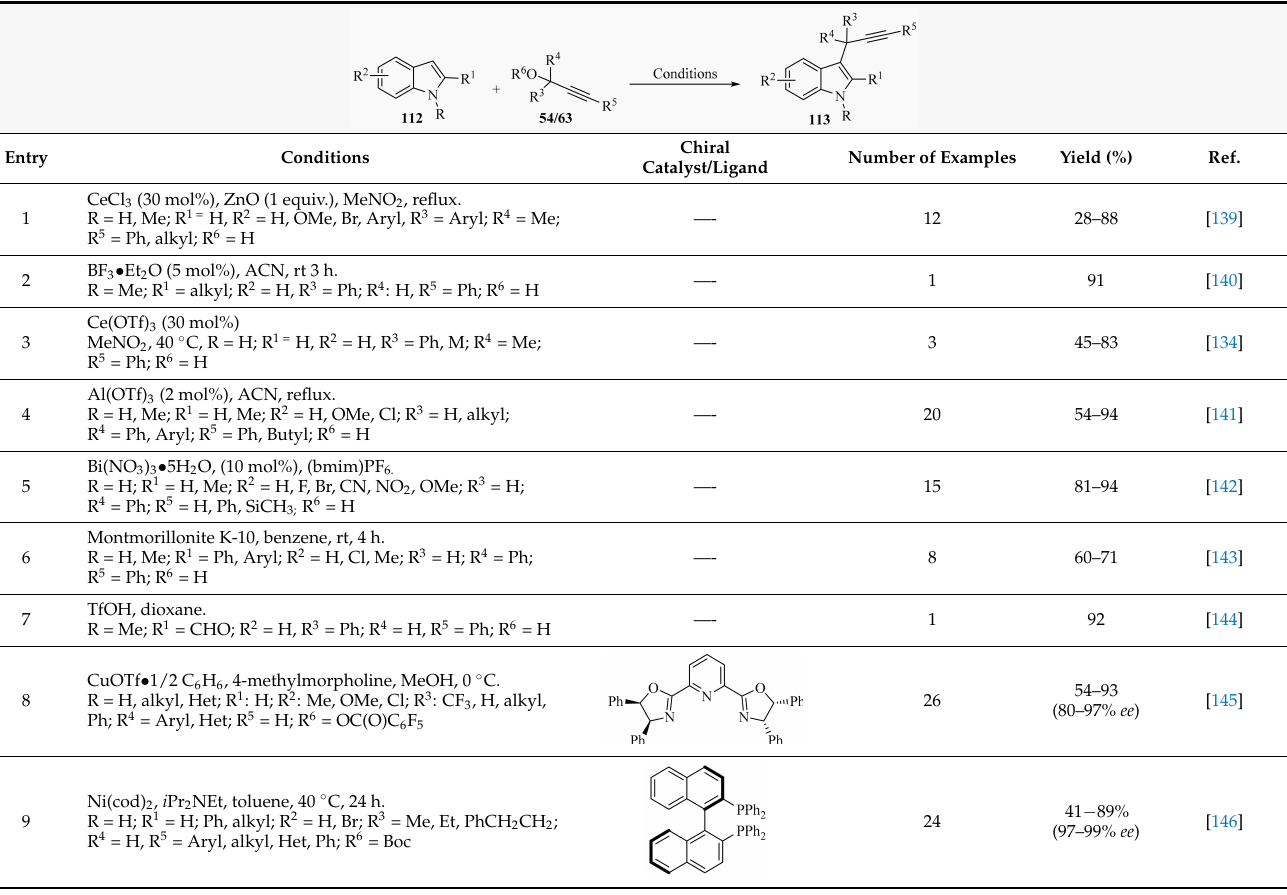
Table 4. Diverse methodologies for the synthesis of propargyl–indole hybrids 113 from substituted propargyl derivatives 54 / 63 and indoles 112